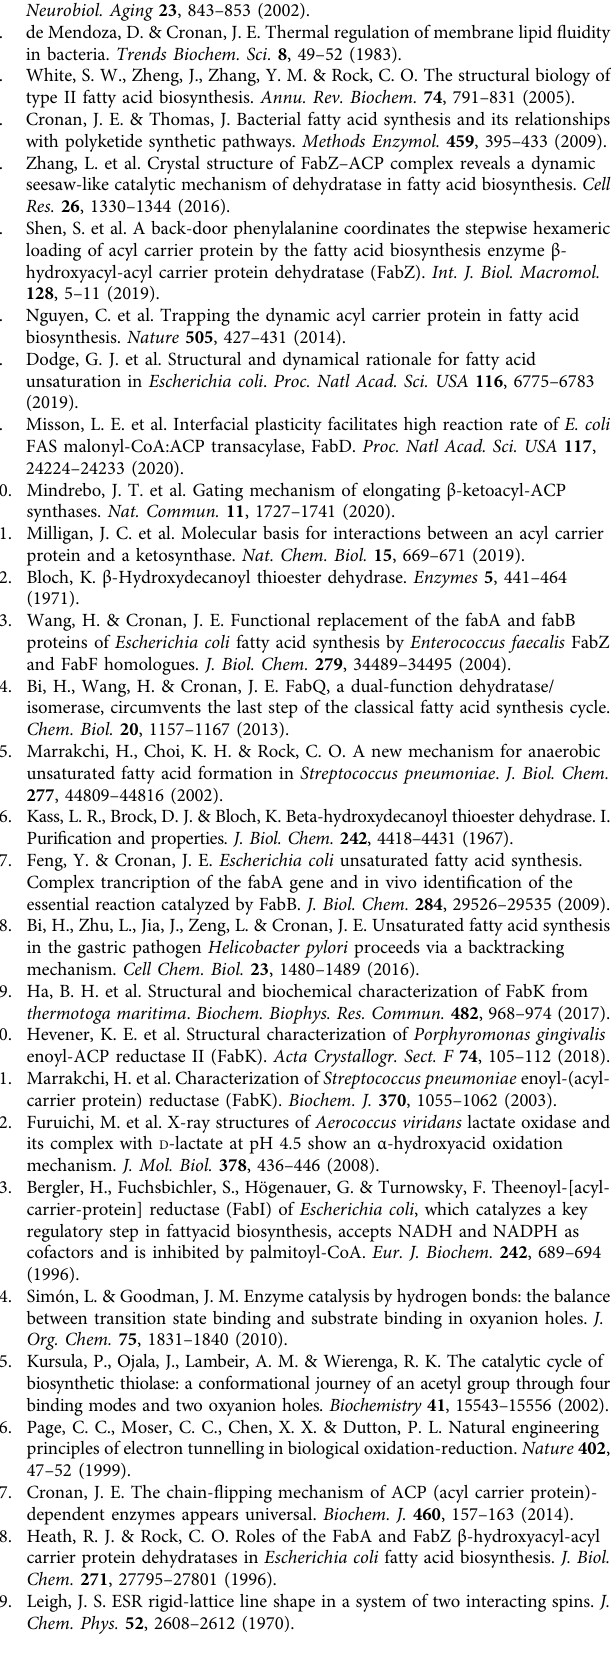
(Table S2). Molecular replacement was used to solved the structures with the TIM- barrel domain structure of P. gingivalis FabK (pdb code: 4IQL) and H. pylori holo- ACP structure (pdb code: 5H9H) as search models, respectively. Subsequently, the data fi le was re fi ned by program Phenix and the model building was conducted via computer graphics program Coot 56,57 . The protein structure viewer was performed by PyMol software. The atomic coordinates and structure factors for the reported crystal structures were deposited under accession codes 7E1Q, 7E1R, and